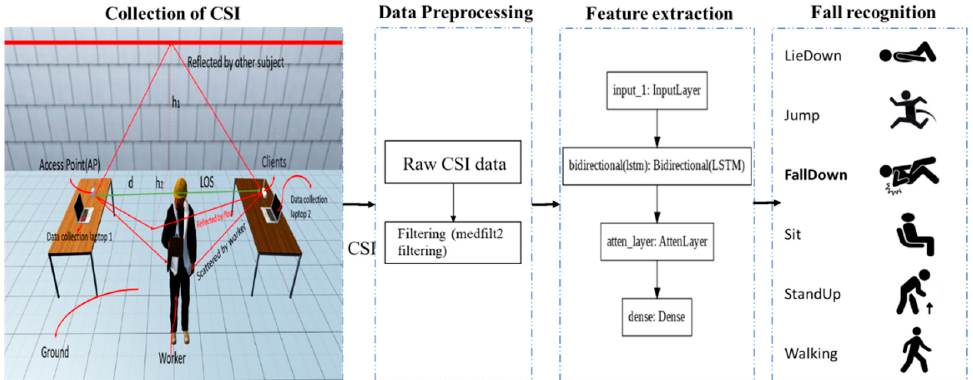
Figure 1. The flowchart for implementing worker fall recognition using